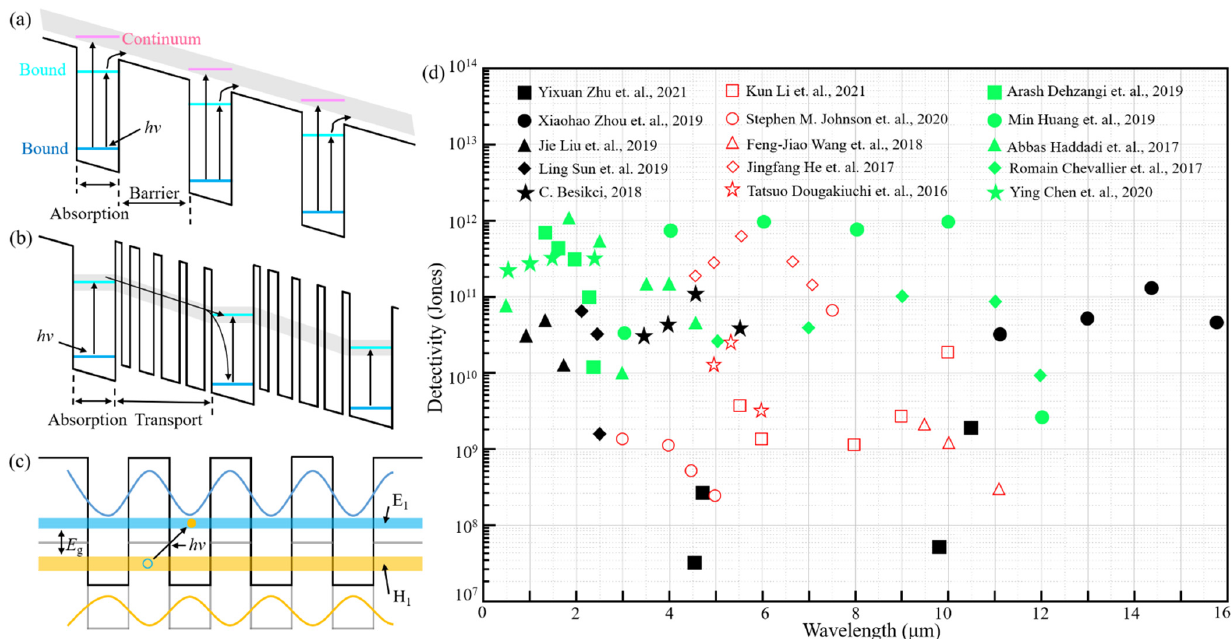
Figure 4. QWIPs and QCDs. ( a ) Carrier transport of QWIPs. ( b ) Carrier transport of QCDs. ( c ) Car- rier transport of T2SL. ( d ) Detectivity as a function of wavelength for QWIPs (black solid point), QCDs (red hollow dot) and T2SL PDs (green solid point). Date from [65, 69, 70, 73–84].